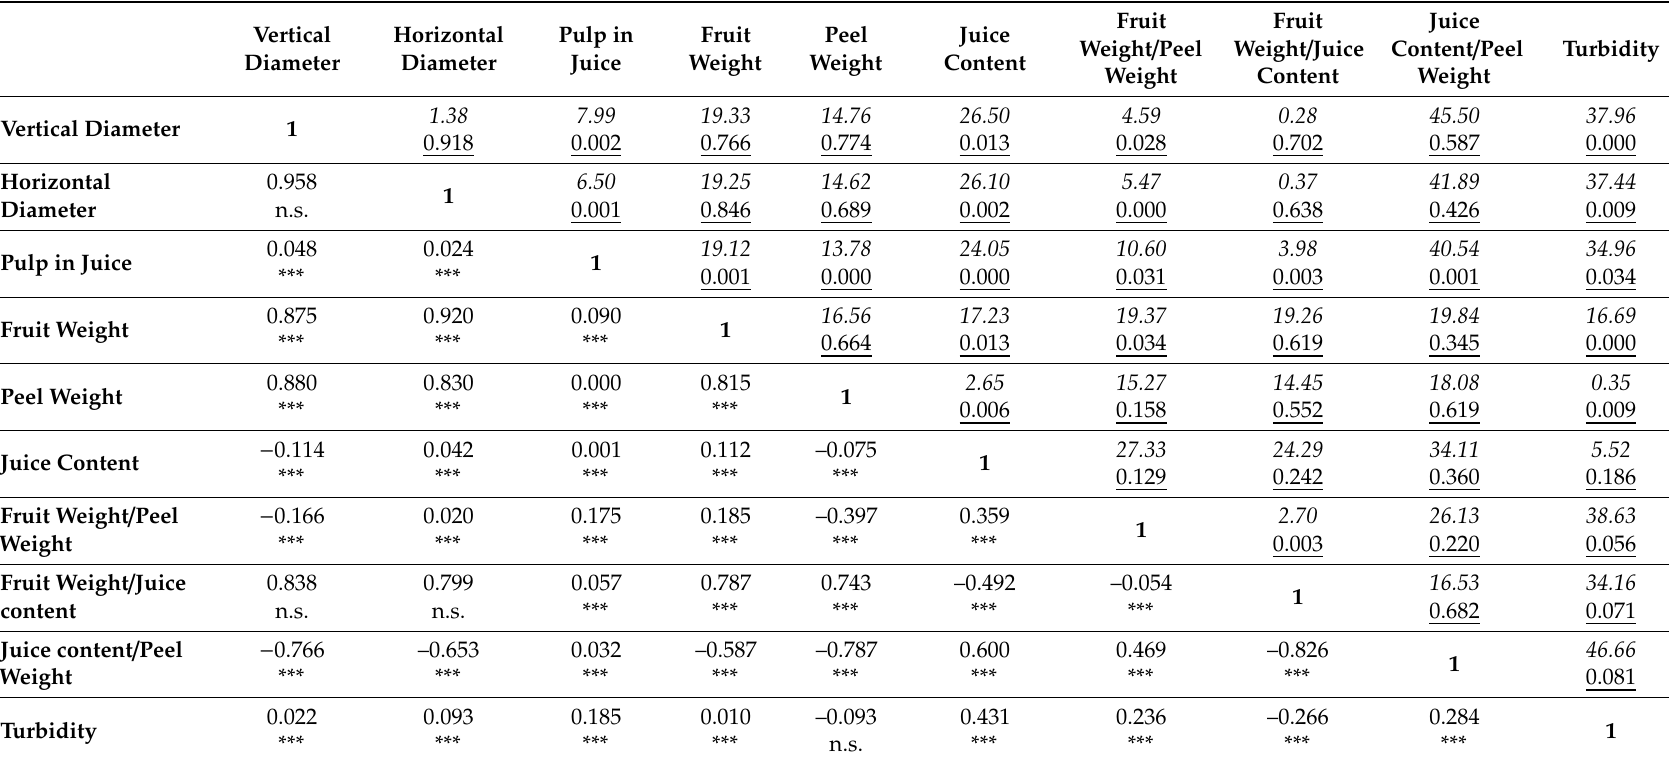
Table 2. The correlation matrix of biometrics is built on the basis of 48 values for each parameter (4 replicates × 2 harvest years × 3 cultivars). In the south-west section of the matrix is the r-value (above) and the significance level (below) with p < 0.001,***; n.s., not significant. In the north-east section of the matrix is the t -value (in italics) with the significance of the t -test calculated at 95% confidence interval and the R 2 value